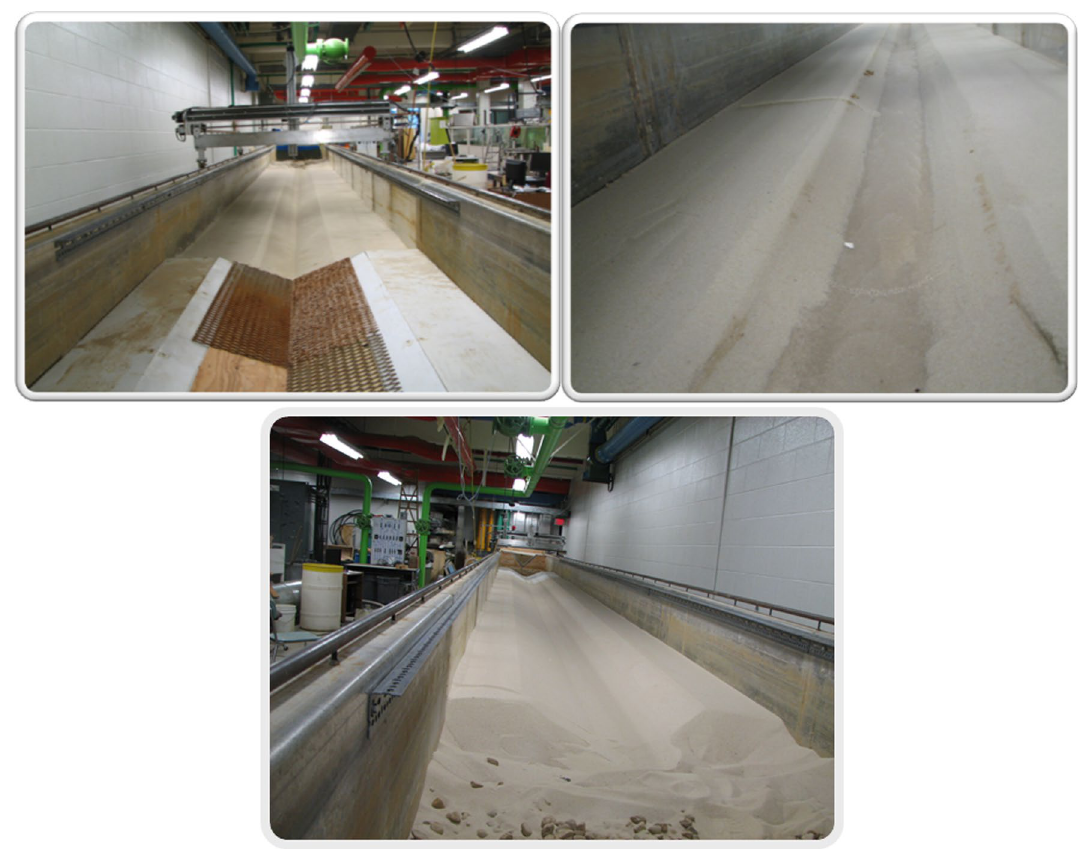
Fig. 2 A view of studied laboratory